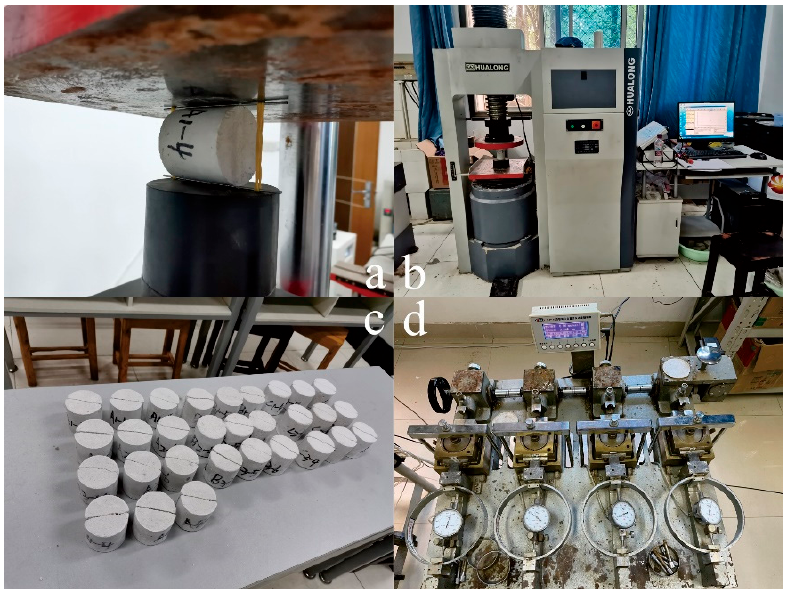
Figure 5. ( a ) Splitting tensile strength test, ( b ) uniaxial compression test, ( c ) specimen, ( d ) direct shear test. Table 1. Physical and mechanical parameters of prototypes and similar materials.